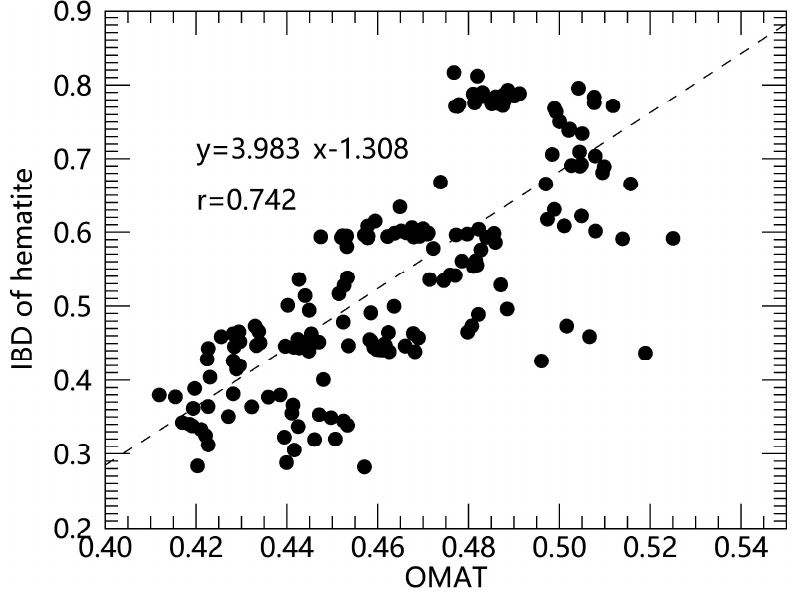
Figure 3. Comparison of hematite abundance with OMAT in the polar regions. The formulas in the figure show the result of linear regression fit and r in the figure represents the linear